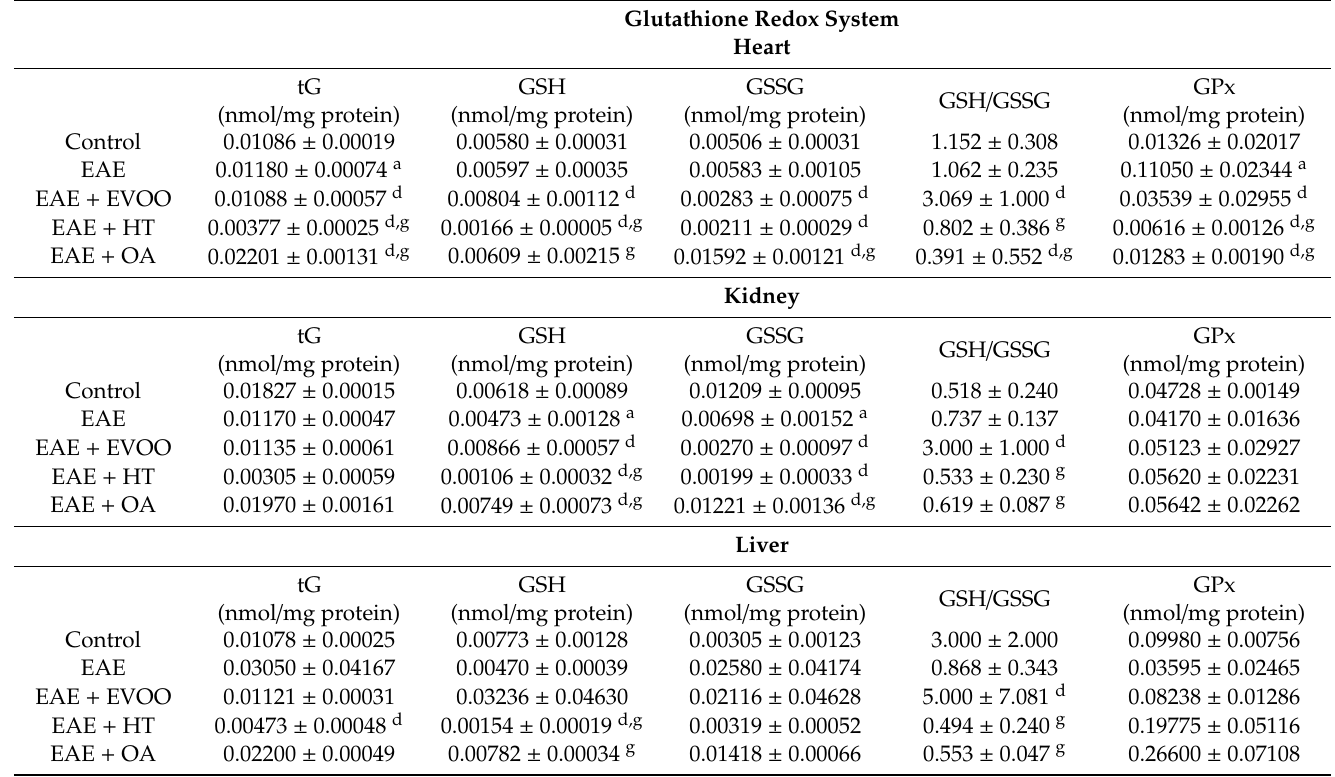
Table 1. Glutathione redox system in the heart, kidney, and